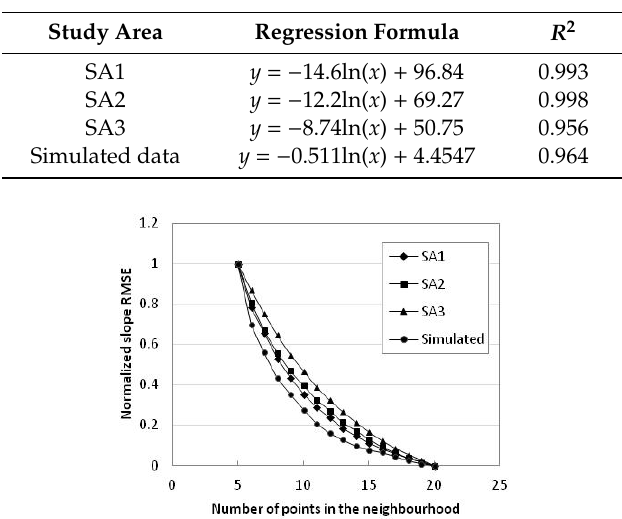
Table 10. Functional relationship between the aspect RMSE ( y ) and the number of points in the neighbourhood ( x ) in study areas 1–3 and simulated data.